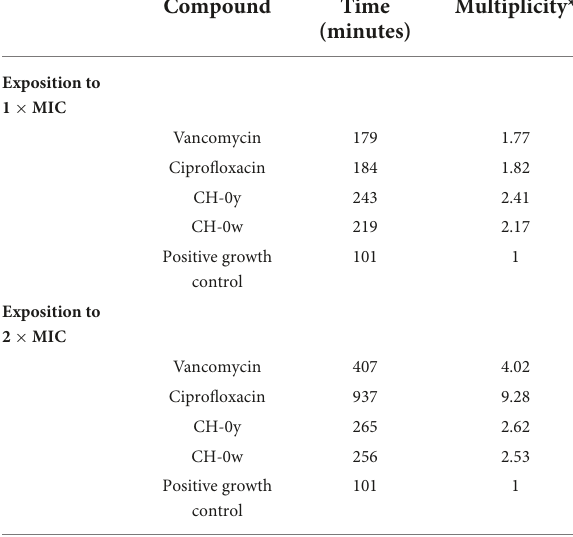
TABLE 3 Post-antimicrobial effect presented as a time delay in the growth of a bacterial strain after 2 h of exposure to CH-0y, CH-0w, and the conventional drugs, vancomycin, and